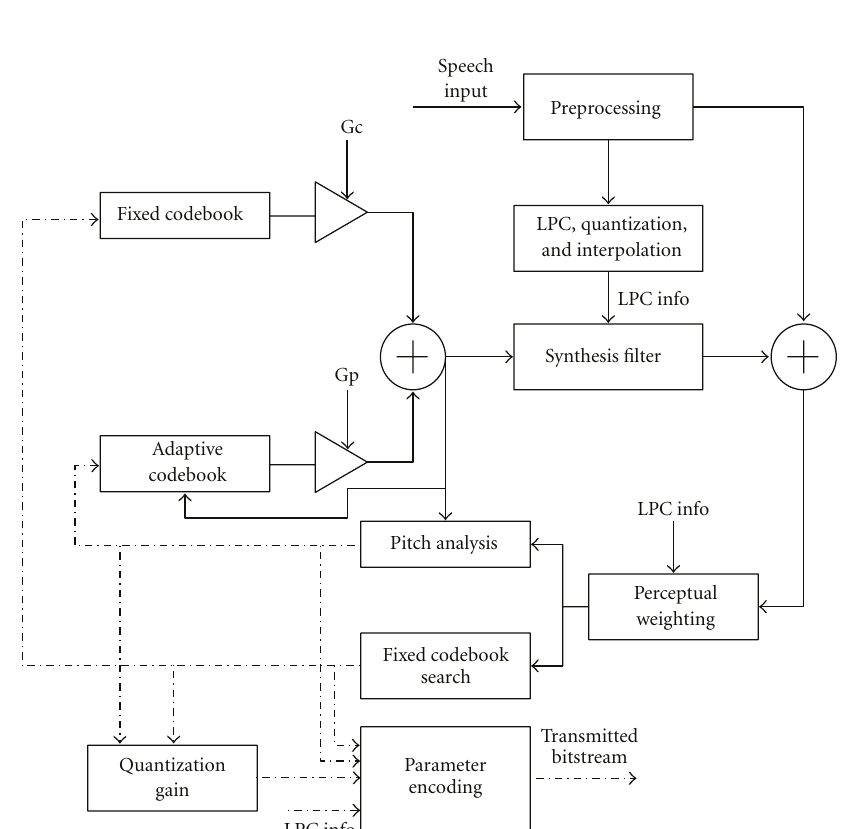
Figure 3: Each superframe encoding mode.